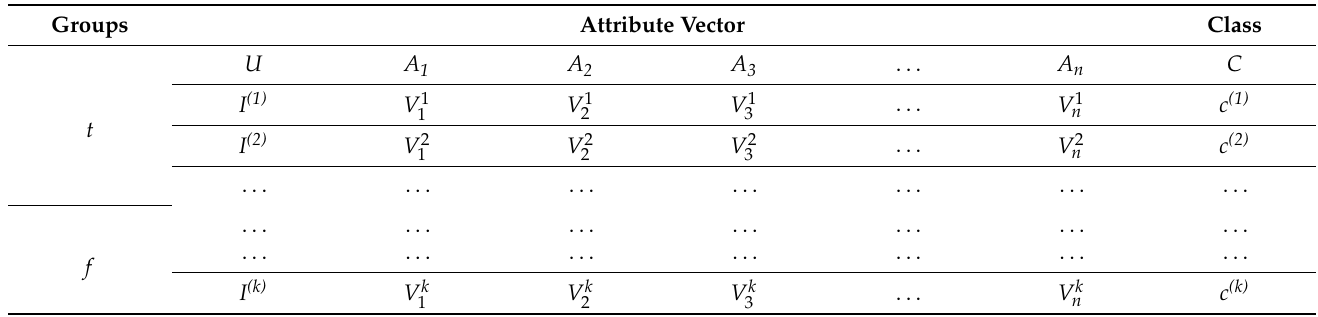
Table 2. Visualization of the research